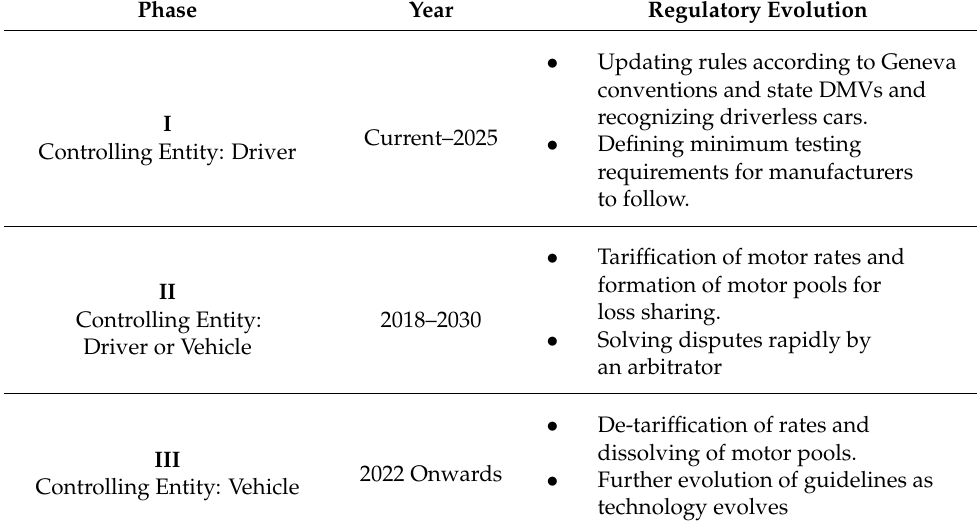
Table 6. Possible future regulatory road adapted from